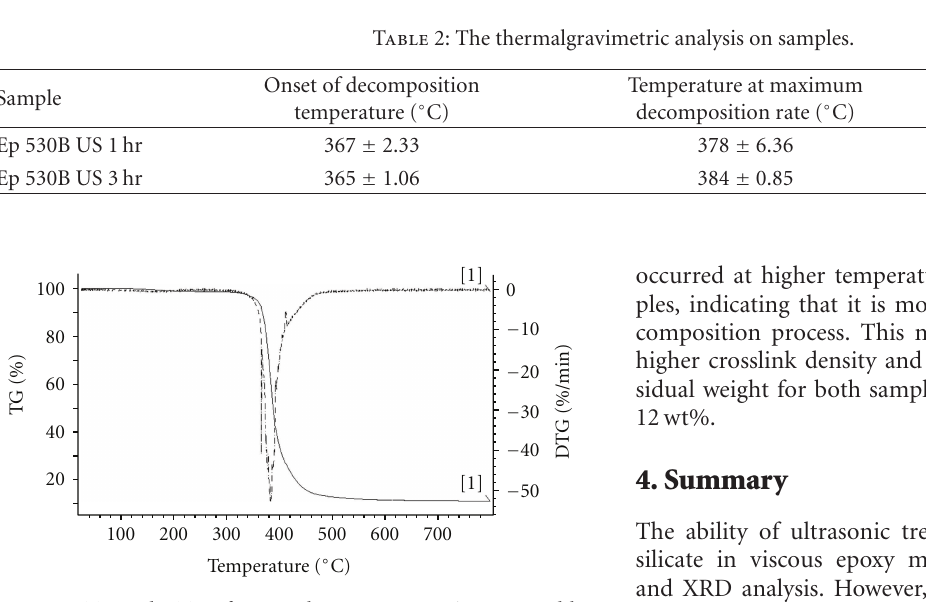
the glass transition process. Lower values of Δ c gp indicate more rigid